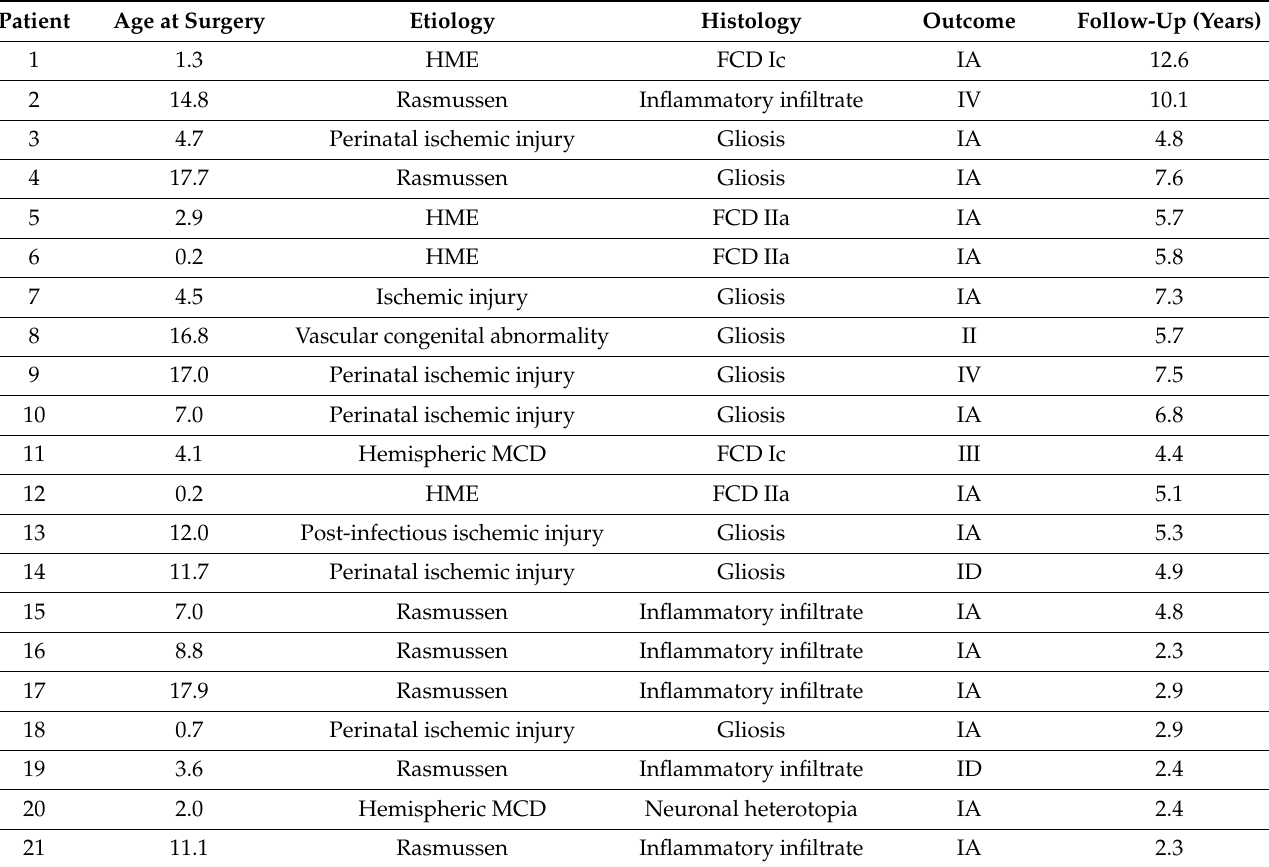
Table 3. Clinical, demographic and epileptological data of our patient cohort. FCD: Focal Cortical Dysplasia; HME: Hemimegaloencephaly; MCD: Malformation of Cortical Development.